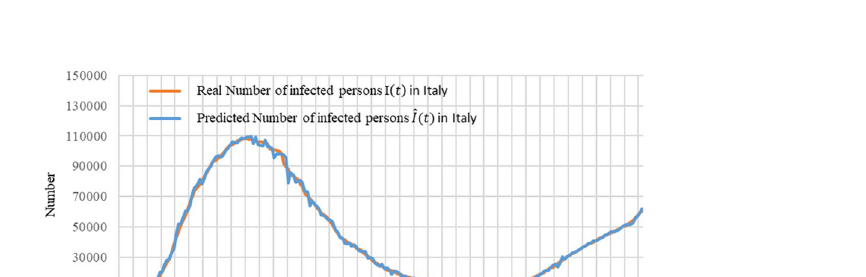
Table 6. The measurement of the reproduction number and the exponential growth rate according to TW-SIR model.